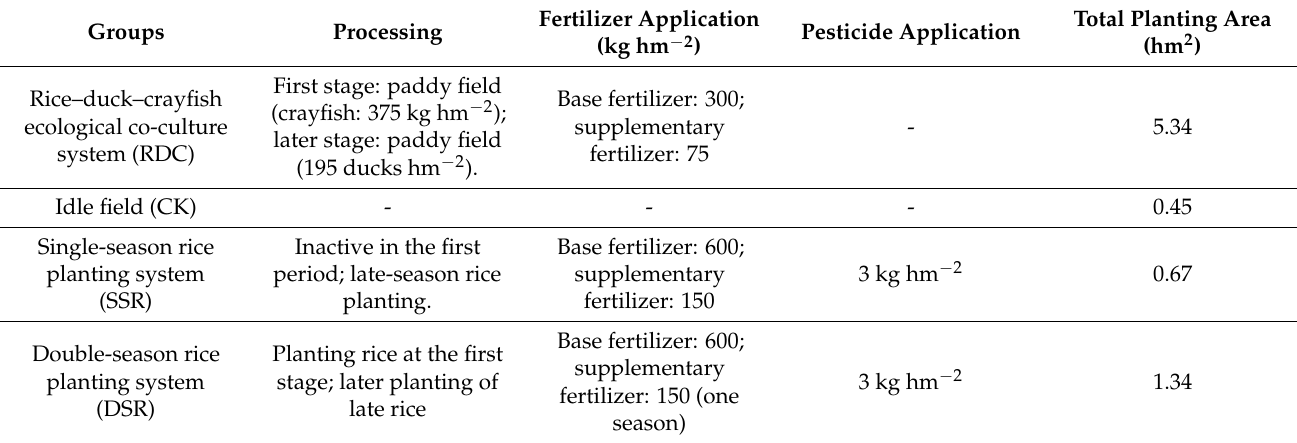
Table 1. Detailed descriptions of different